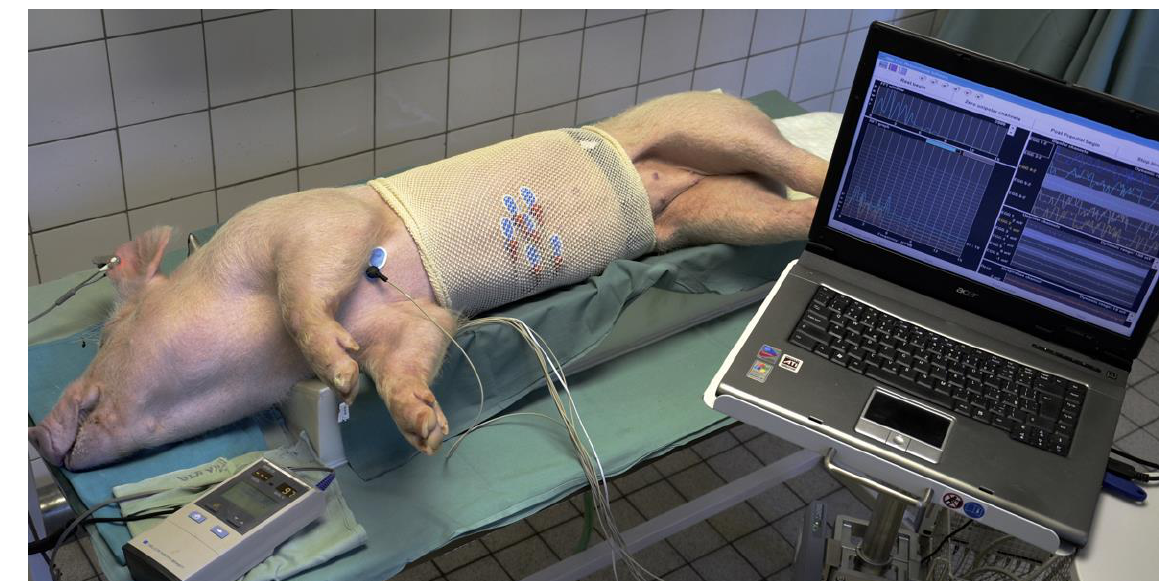
Figure 11. Arrangement of electrogastrography in experimental pigs. All recordings were accomplished under general propofol anaesthesia. Monitoring of vital functions was performed throughout the procedures.